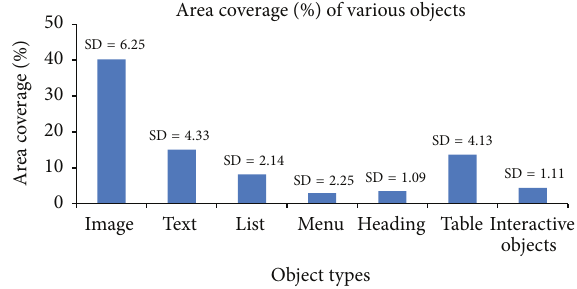
Figure 7: The histogram showing the average area occupied by the different objects in the sample web pages.